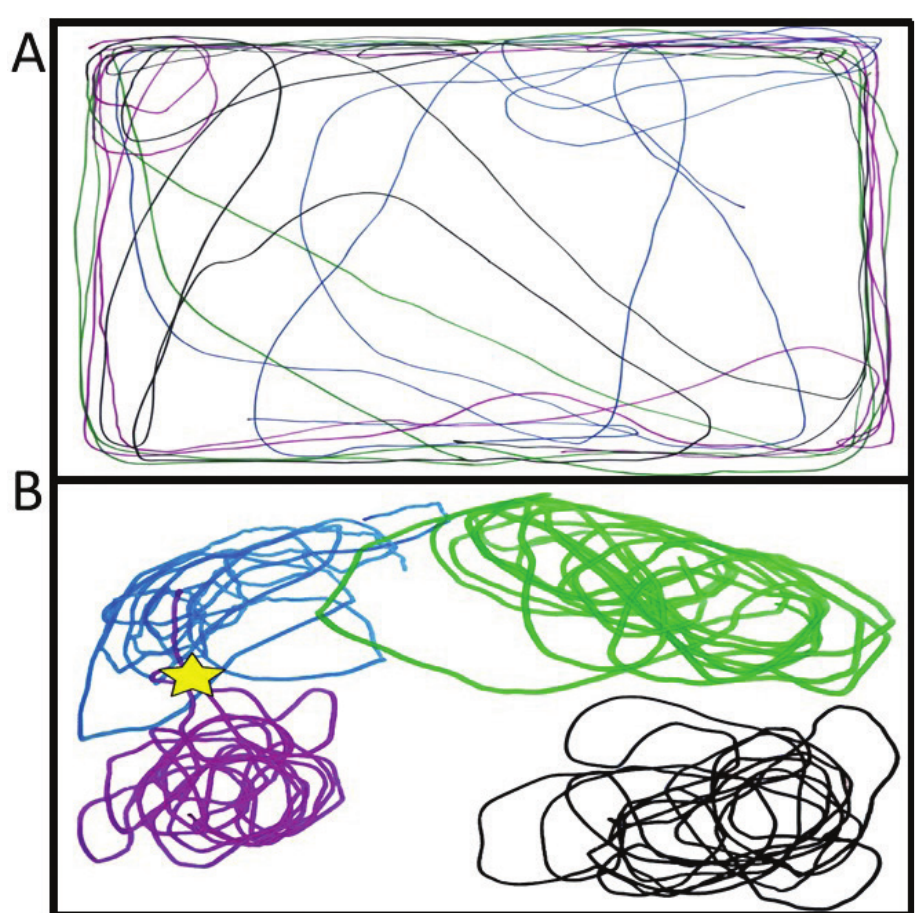
Figure 4. Territoriality from a top view of a tank. Black straight lines represent edges of the tanks (size 20cm X 40cm). Colored lines follow the swimming paths of four individuals over a 1 min period. A Thin lines follow four Pachón cavefish. B Thick lines follow four eyeless Caballo Moro cavefish. Yellow star signals an attack. Specimens used for both cavefish populations are eyeless. Notice that while all Pachón fish swim throughout the entirety of the tank and the paths of individual fish converge over the paths of other individuals, those of Caballo Moro are mostly restricted to a corner, and each individual holds a territory seldom crossed by another individual. However, when they do cross, it can result in an